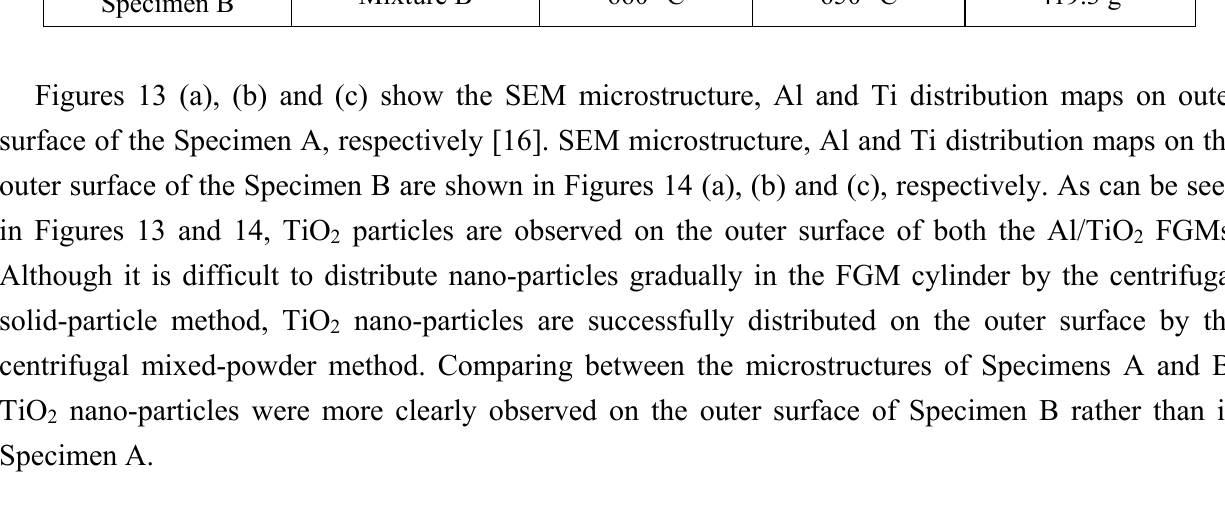
Figure 13. SEM microstructure, Al and Ti distribution maps on outer surface of the Specimen A